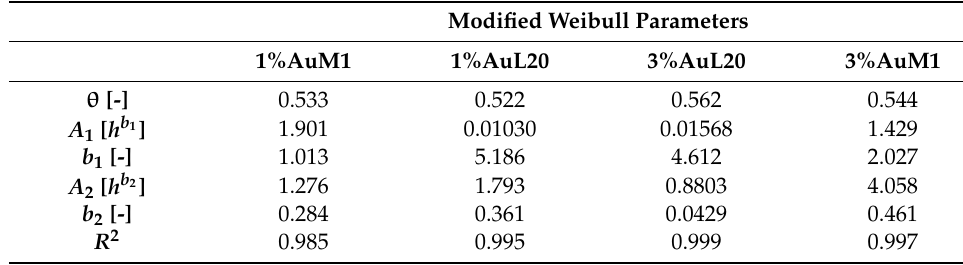
Table 6. Modified Weibull Model parameters.